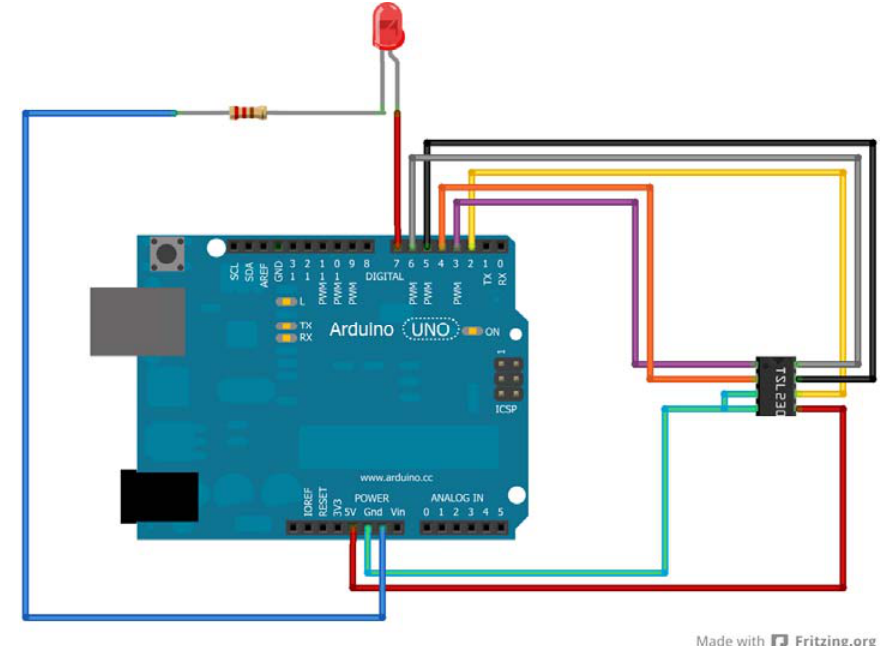
Figure 2. The open-source colorimeter circuit